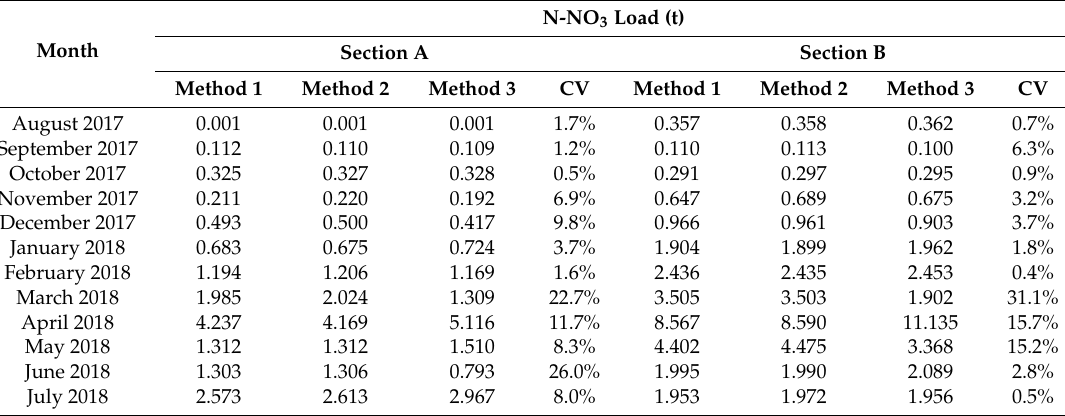
Table 3. Monthly N-NO 3 loads estimated by using the inter-sample mean concentration (Method 1), inter-sample mean concentration using mean flow (Method 2), and linear interpolation of concentration (Method 3) methods. CV is the coefficient of variation.